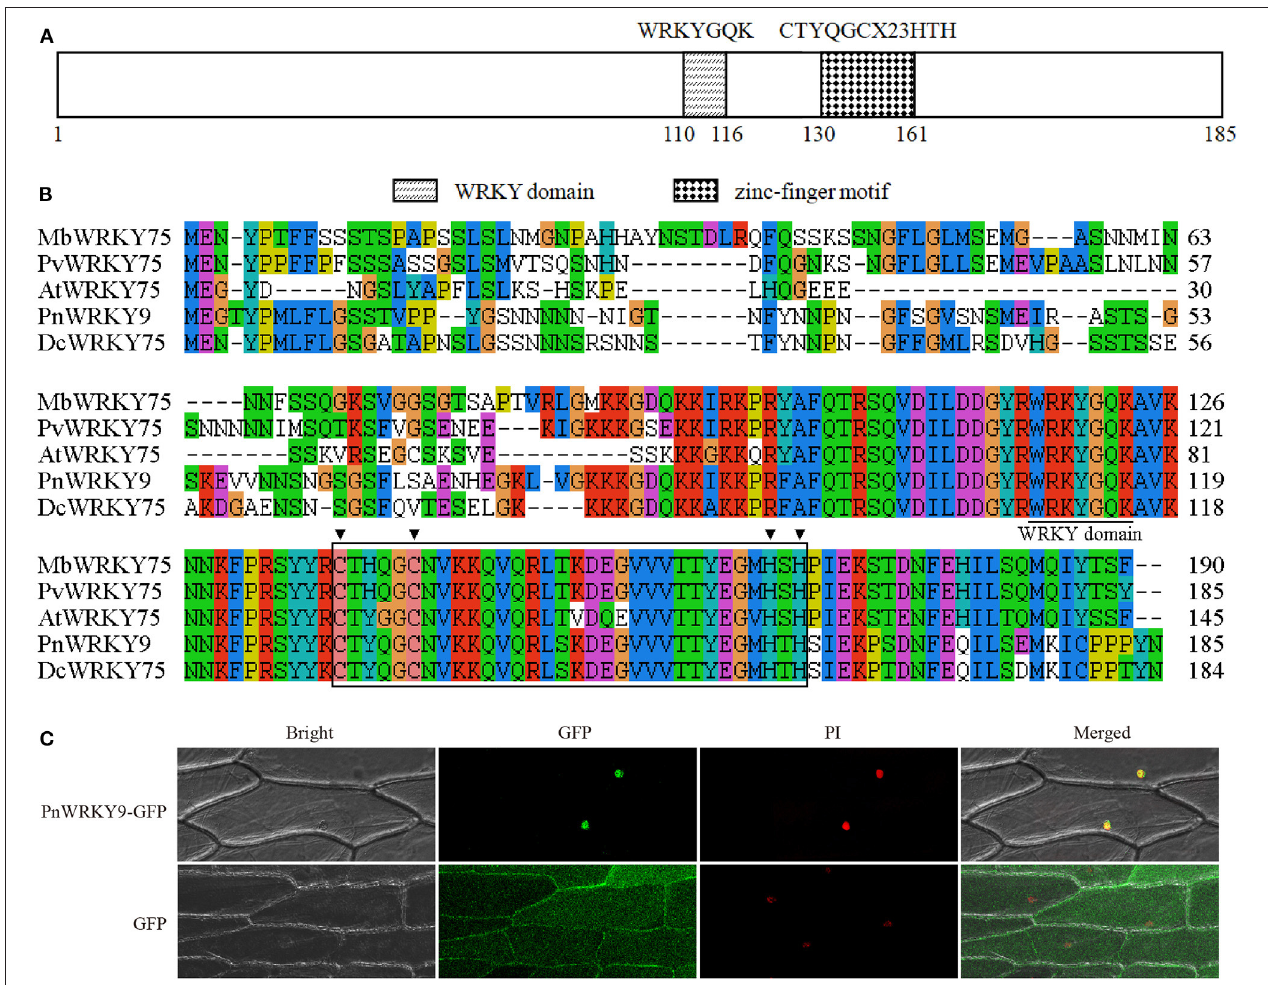
FIGURE 4 | Sequence and subcellular localization analyses of PnWRKY9. (A) The structure schematic of PnWRKY9 protein. (B) Multiple sequence alignment of PnWRKY9 and homologous WRKY proteins using clustalx1.83 software. (C) Subcellular localization analysis of PnWRKY9-GFP fusion protein. Bright, white light field; GFP, green fluorescent field; PI, propidium iodide, which was used to indicate the nucleus; Merged, mixed field.